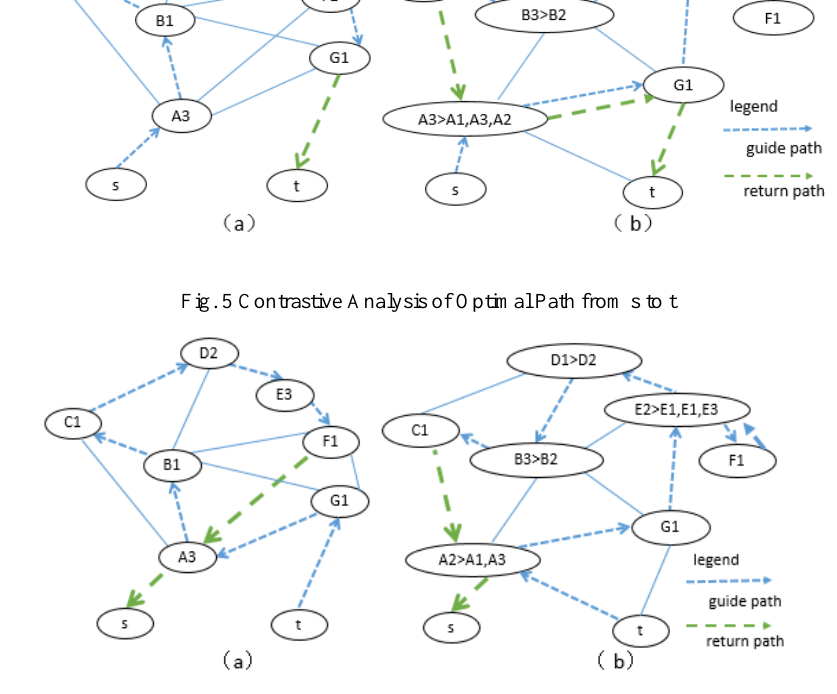
Fig. 6 Contrastive Analysis of Optimal Path from t to s